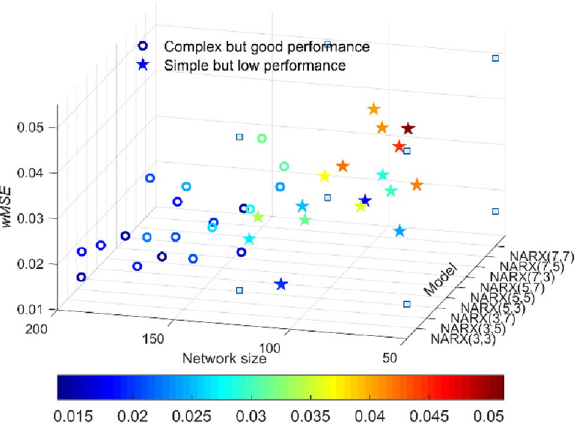
Figure 6. The appearance of k = 2 clusters of NARX-NN models for S2 case. Resulting clusters indicate that any networks with a number of parameters less than 150 should be considered as a simple prediction model.